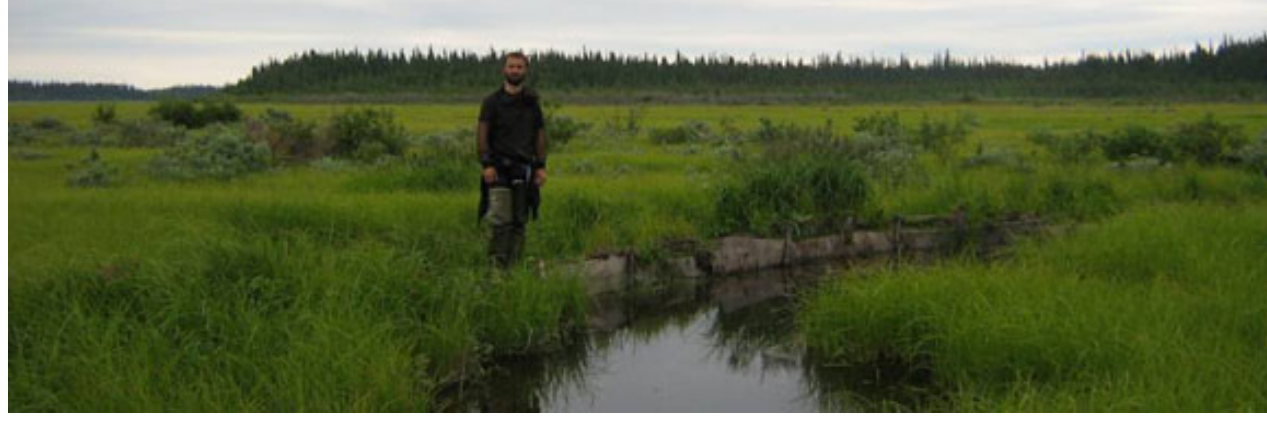
Fig. 2 . A large dyke used for hunting geese. This dyke is 180 meters long and extends beyond the